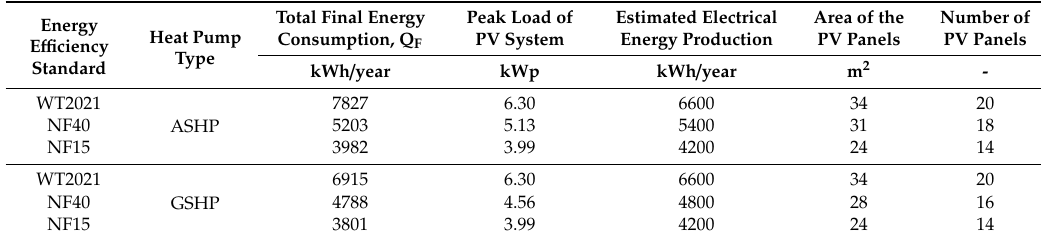
Table 12. Selection of photovoltaic panels for the WT2021, NF40 and NF15